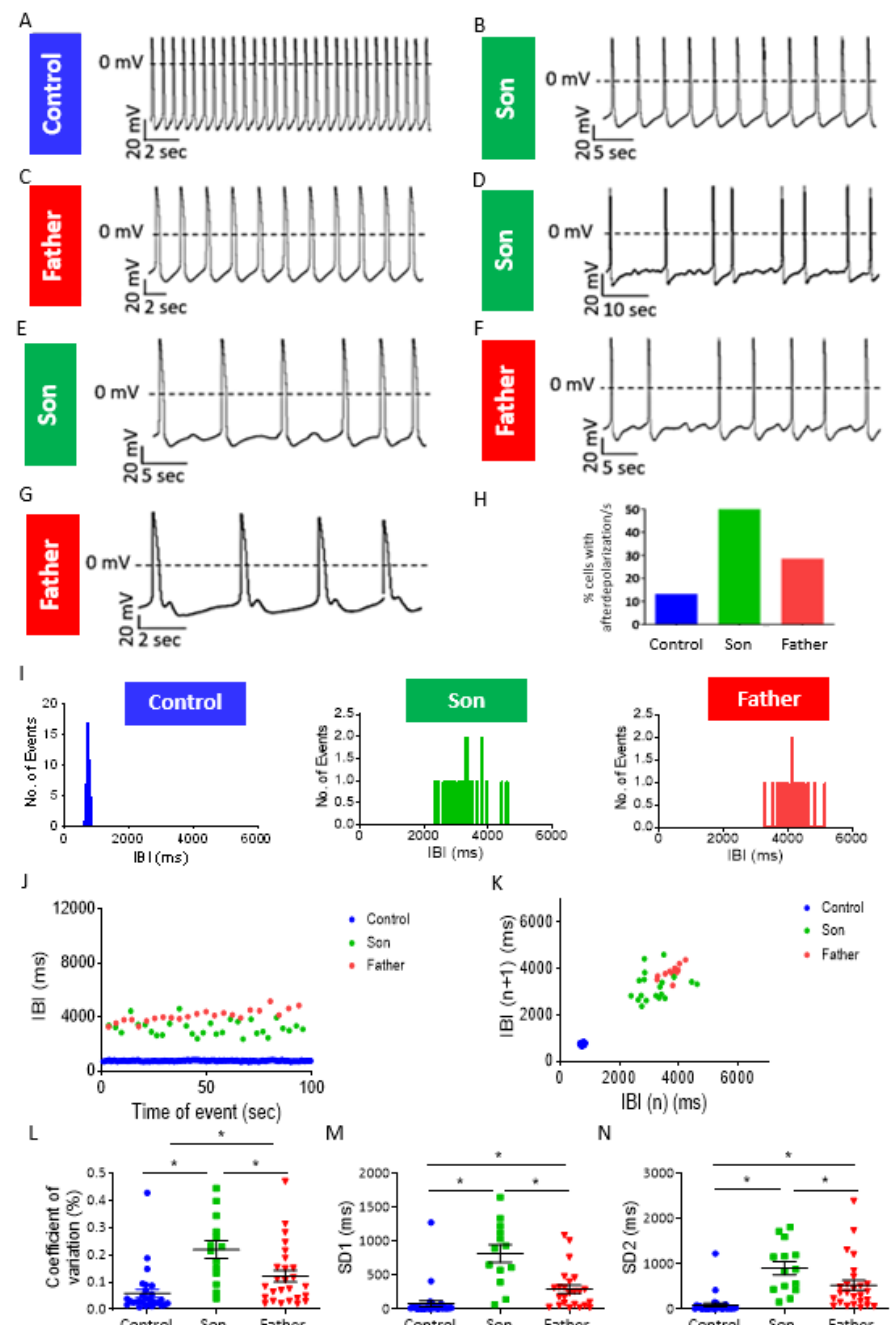
Figure 5. Afterdepolarizations and increased BRV in son and father LMNA -mutated iPSC-CMs. ( A – C ) Representative recordings showing afterdepolarization-free spontaneous activity in control, son and father cardiomyocytes. ( D , E ) Spontaneous AP recordings demonstrating DADs in son iPSC-CMs. ( F , G ) Spontaneous AP recordings demonstrating afterdepolarizations in father iPSC-CMs. ( H ) Percentage of experiments with afterdepolarization/s in control, son and father cardiomyocytes ( n = 30 control (FSE-5 m and 24.5); n = 14 son; n = 28 father). ( I ) Representative IBI histograms in control, son and father cardiomyocytes. ( J ) Superimposed representative IBI vs. time plots of control, son and father iPSC-CMs. ( K ) Superim- posed representative Poincar é plots of control, son and father iPSC-CMs. ( L ) COV analysis in control, father and son cardiomyocytes. ( M ) SD1 analysis in control, father and son cardiomyocytes. ( N ) SD2 analysis in control, father and son cardiomyocytes. Control (FSE-5 m and 24.5), n = 30; son, n = 14; father, n = 27. One-way ANOVA was performed followed by Holm–Sidak post hoc analysis. * p <